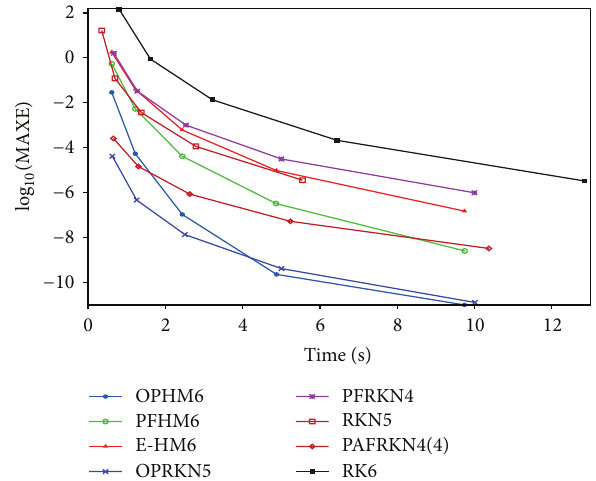
Figure 12: The efficiency curves of the optimized order six method = 10 4 and ℎ = 1 − and their comparisons for Problem 6 with 𝑡 end 2 𝑖 , 𝑖 = 1,...,5